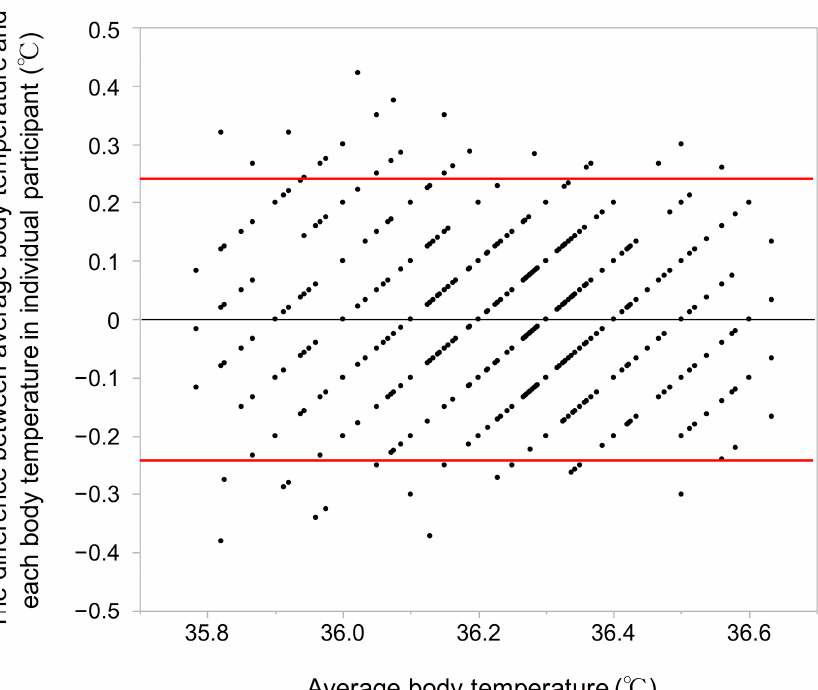
Figure 1. Bland-Altman plot assessing body temperature variation of a non-contact infrared ther- mometer between average body temperature and each body temperature in individual participant at baseline and at 2 years. The upper and lower limits of agreement were set at two standard devi- ations from the mean (red lines). Black line indicates mean difference.